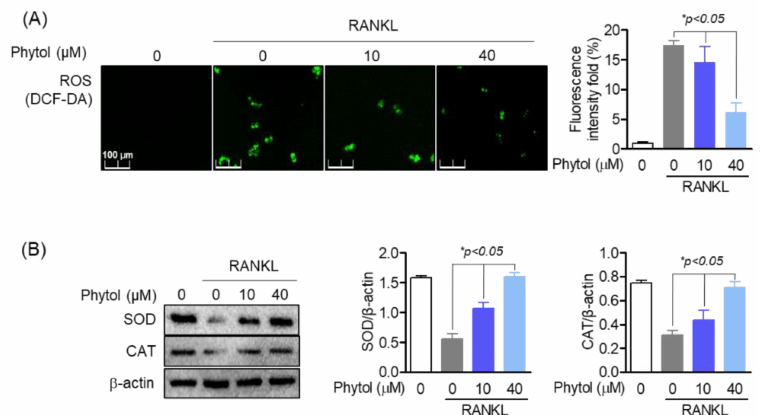
Figure 6. Reduced effect of phytol on oxidative stress markers in receptor activator of nuclear factor kappa − B ligand (RANKL)-induced osteoclasts. ( A ) 2 (cid:48) ,7 (cid:48) − dichlorodihydrofluorescein diacetate (DCF- DA) was used to investigate reactive oxygen species (ROS) accumulation in 10 − 40 µ M phytol-treated cells. ( B ) The recovery of antioxidant enzymes including superoxide dismutase (SOD) and catalase (CAT) was measured by Western blot analysis and normalized to that of β -actin. Data are presented as the mean of three independent experiments (Mean ±